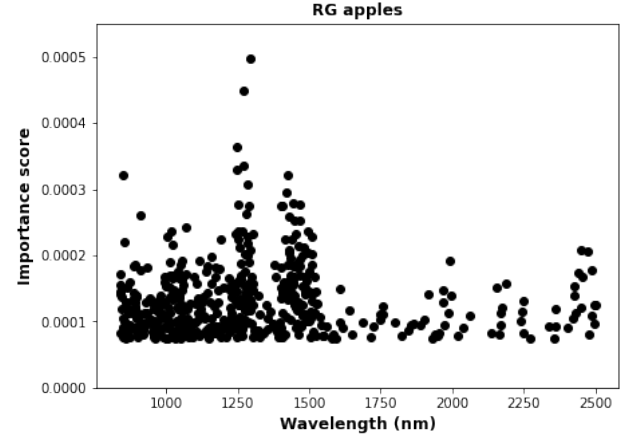
Figure 3. The graph shows the permutation importance for the top 500 features/wavelength.